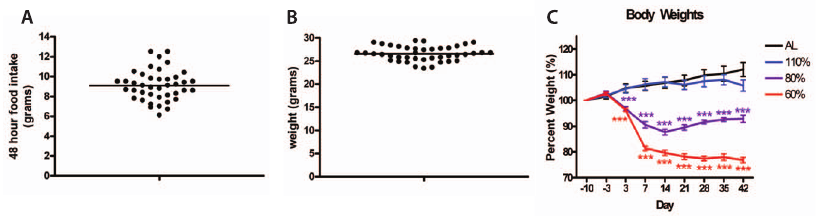
Figure 2. Food intake and body weight distribution and normalized body weights of mice on different food restriction amounts. (A) Individual measurements of food intake over a 48 hour period for individual mice divided by 2 to give a 24 hour food intake (n=42). (B) Individual measurements of body weight prior to any dietary change (day 2 10) (n=42). (C) Mean body weight measurements + / 2 SEM of each treatment group over the duration of the experiment. Mice fed AL (black; n=8), 110% (blue, n=8), 80% (purple; n=8) and 60% (red; n=10) show dose- dependent changes in body weight depending on food availability. Significance was tested with Tukey-Kramer multiple comparisons test with one- way ANOVA post-test for all treatment groups vs. AL controls for each respective day. ***denotes p , 0.001.